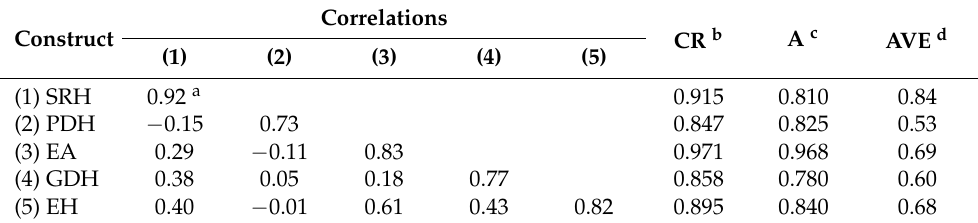
Table 1. Reliability, convergent, and discriminant validity of measurement